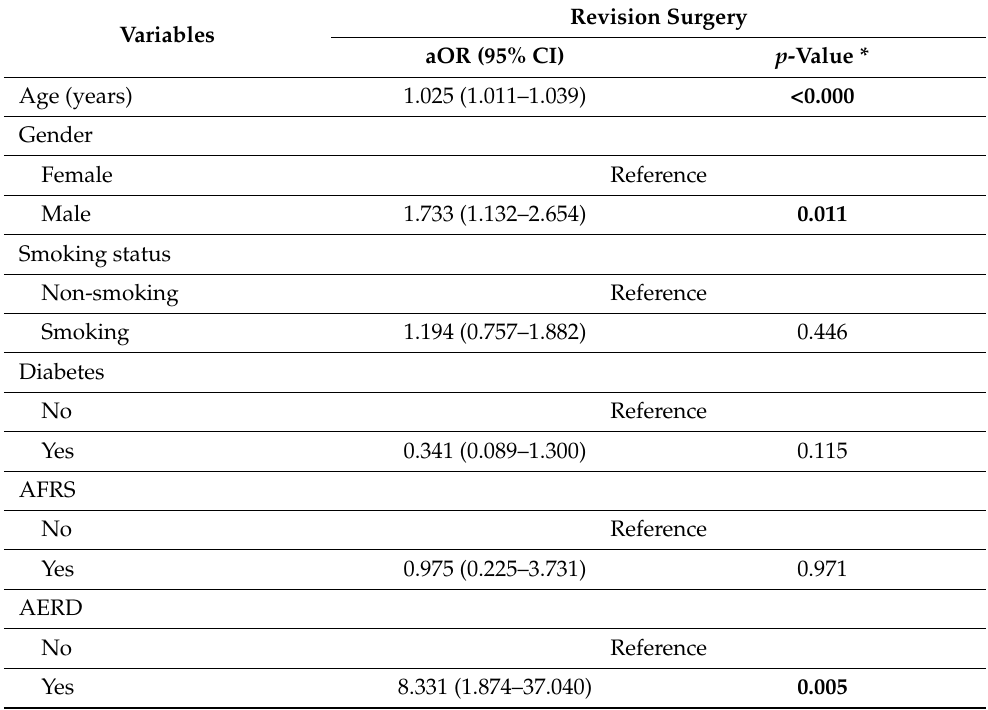
Table 3. Results of binary logistic regression analysis with the factors of age (years), gender (male/female), smoking status (smoking/non-smoking), diabetes (yes/no), allergic fungal rhinosi- nusitis, AFRS (yes/no), aspirin-exacerbated respiratory disease, AERD (yes/no), allergies (yes/no), asthma (yes/no) and polyps (yes/no) as explanatory variables in order to generate statistical estimates to calculate adjusted odds ratios (aOR) and 95% confidence intervals